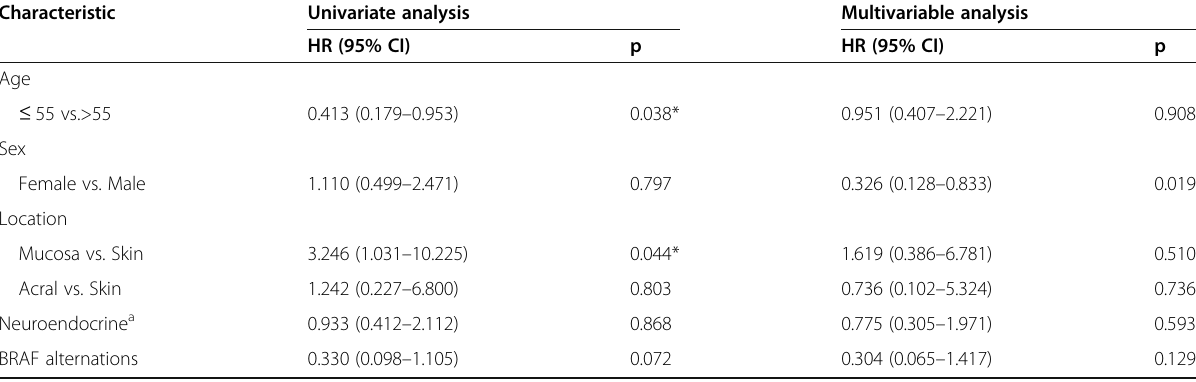
Table 6 Univariate and multivariable Cox proportional hazards model for OS in stage I-II melanoma patients